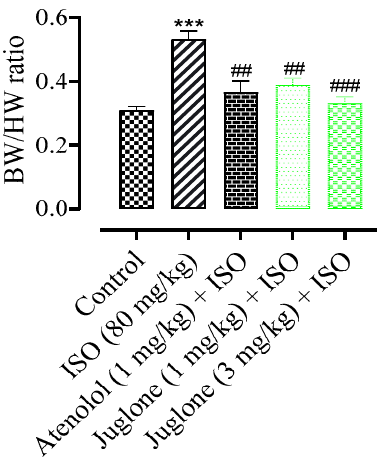
Figure 3. Effect of juglone + ISO, atenolol + ISO and ISO alone on body weight/heart weight (BW/HW) ratio in comparison to control. Values are expressed as mean ± SEM (n = 6), ehere ## p < 0.01 vs. ISO, ### p < 0.001 and *** p < 0.001 vs. control (one-way ANOVA followed by a Tukey’s test).